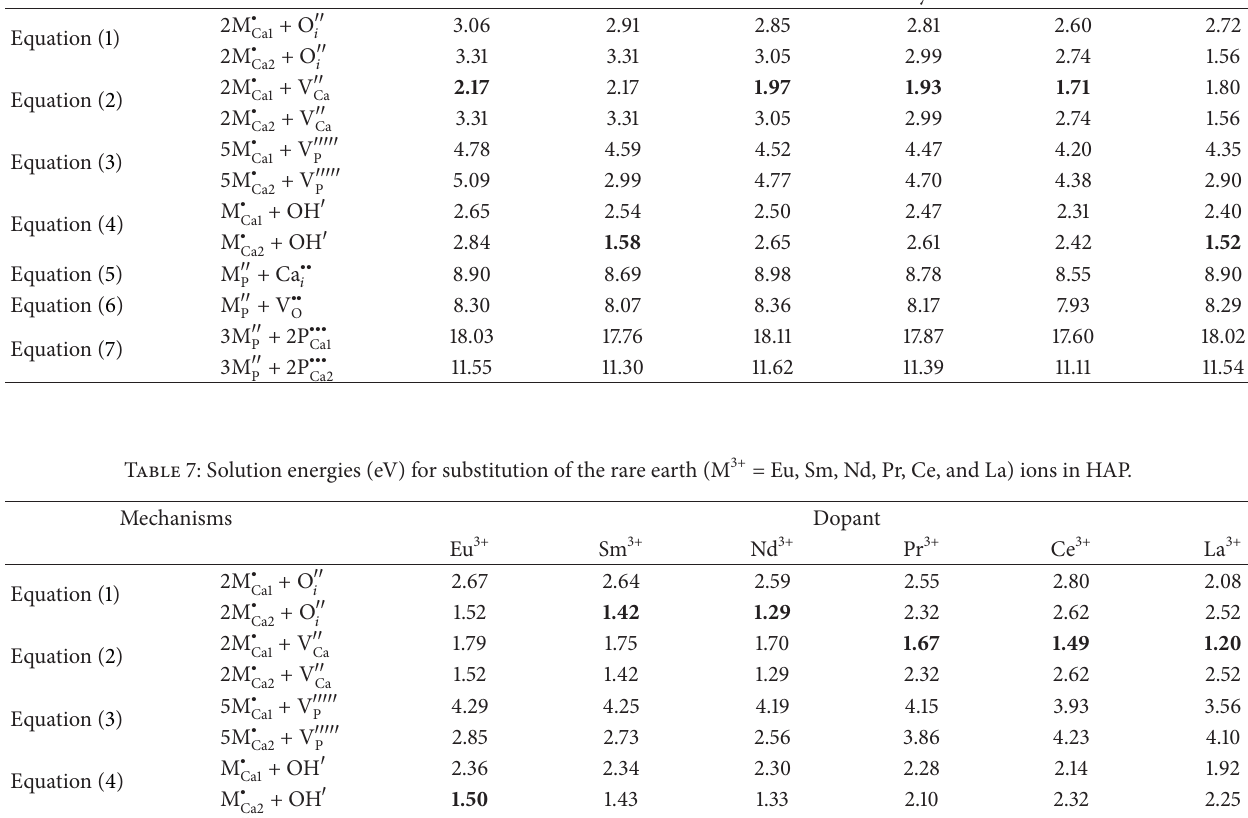
Table 6: Solution energies (eV) for substitution of the rare earth (M 3+ = Tm, Er, Ho, Dy, Tb, and Gd) ions in HAP. Mechanisms